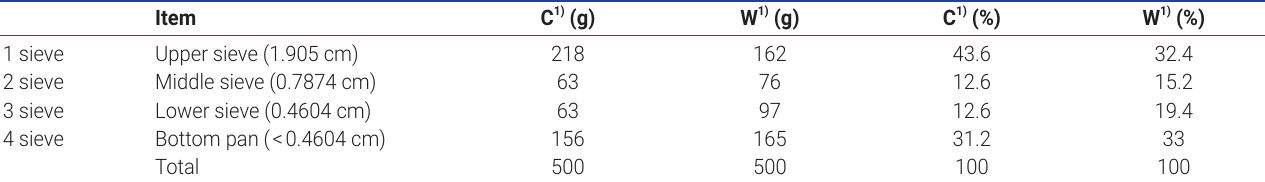
Table 3. The measurement of the particle size of total mixed ration